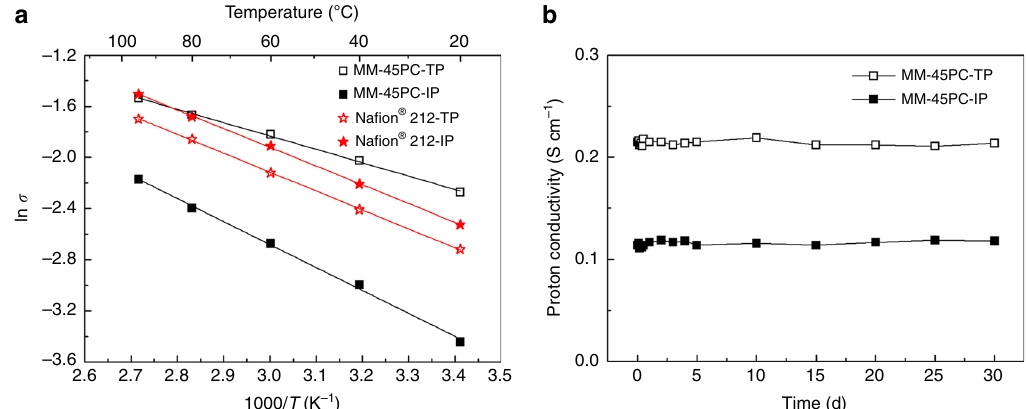
Fig. 9 Proton conductivities of hydrated membranes measured in water. a Temperature-dependent TP and IP proton conductivities of MM-45PC and Na fi on ® 212. Compared with Na fi on ® 212, MM-45PC displays strongly anisotropic proton conductivity, where the TP proton conductivity is much higher than the IP conductivity, and the activation energy is lower than Na fi on ® 212 and MM-45PC-IP. b Long-term stability tests for TP and IP proton conductivities of MM-45PC at 95 °C in water. No reduction is observed within 30 days. TP: through-plane; IP: in-plane; MM-45PC: magnetic-cast membrane with 45 wt% loading of proton-conducting components. Source data are provided as a Source Data fi